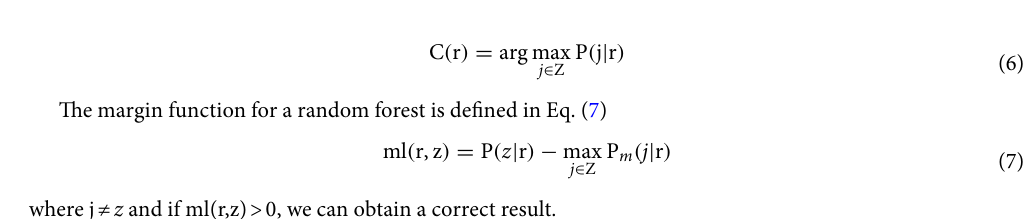
Figure 6. Represents the ground truth image, false-color composite image, and labeled image of the patches of Houston City, Texas(USA) ( a ) Google Earth image, ( b ) the false-color composite image, and ( c ) Ground truth label for Patch1, ( d ) Google Earth image, ( e ) the false-color composite image of G4U decomposition, and ( f ) ground truth label for